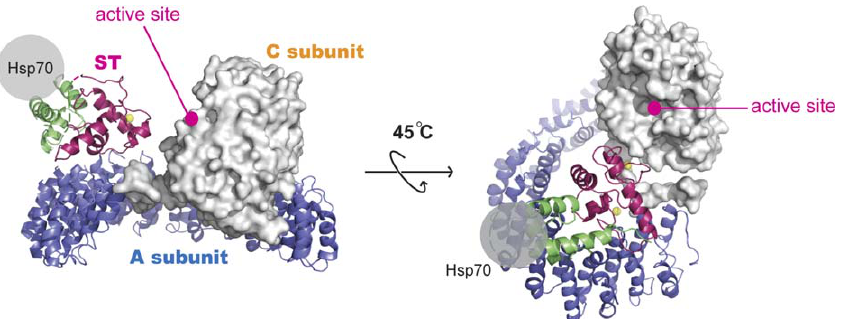
Figure 5. The First Zinc-Binding Motif May Directly Interact with and Inhibit the Catalytic C Subunit of PP2A The structures of the A-ST and A-B56-C complexes are superimposed. The PP2A catalytic subunit is shown in the surface model. The active site of the PP2A C subunit is indicated. The potential binding site of Hsp70 is represented by a gray